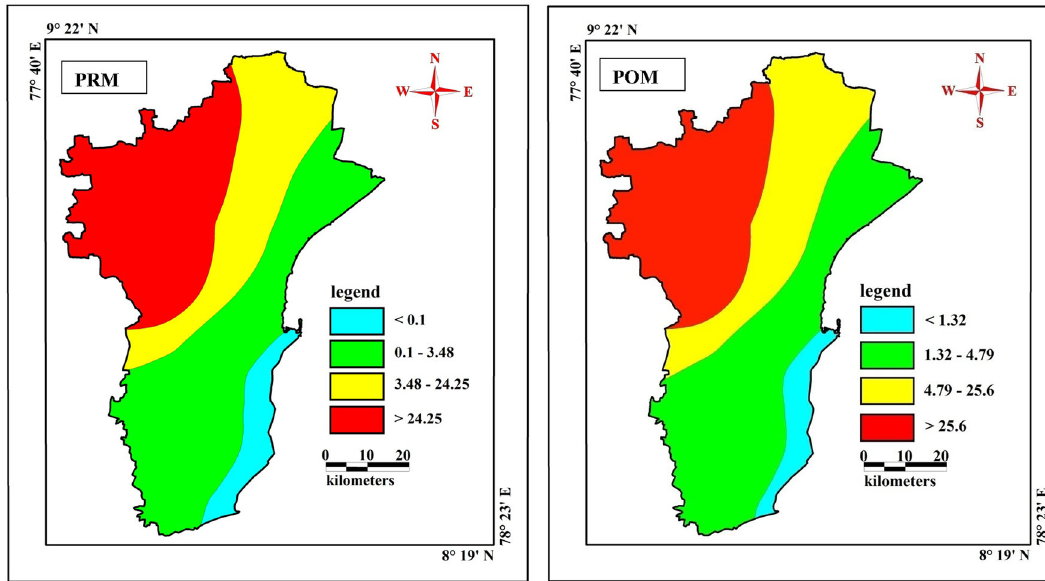
Fig. 8 Depth to water level during PRM and POM (m